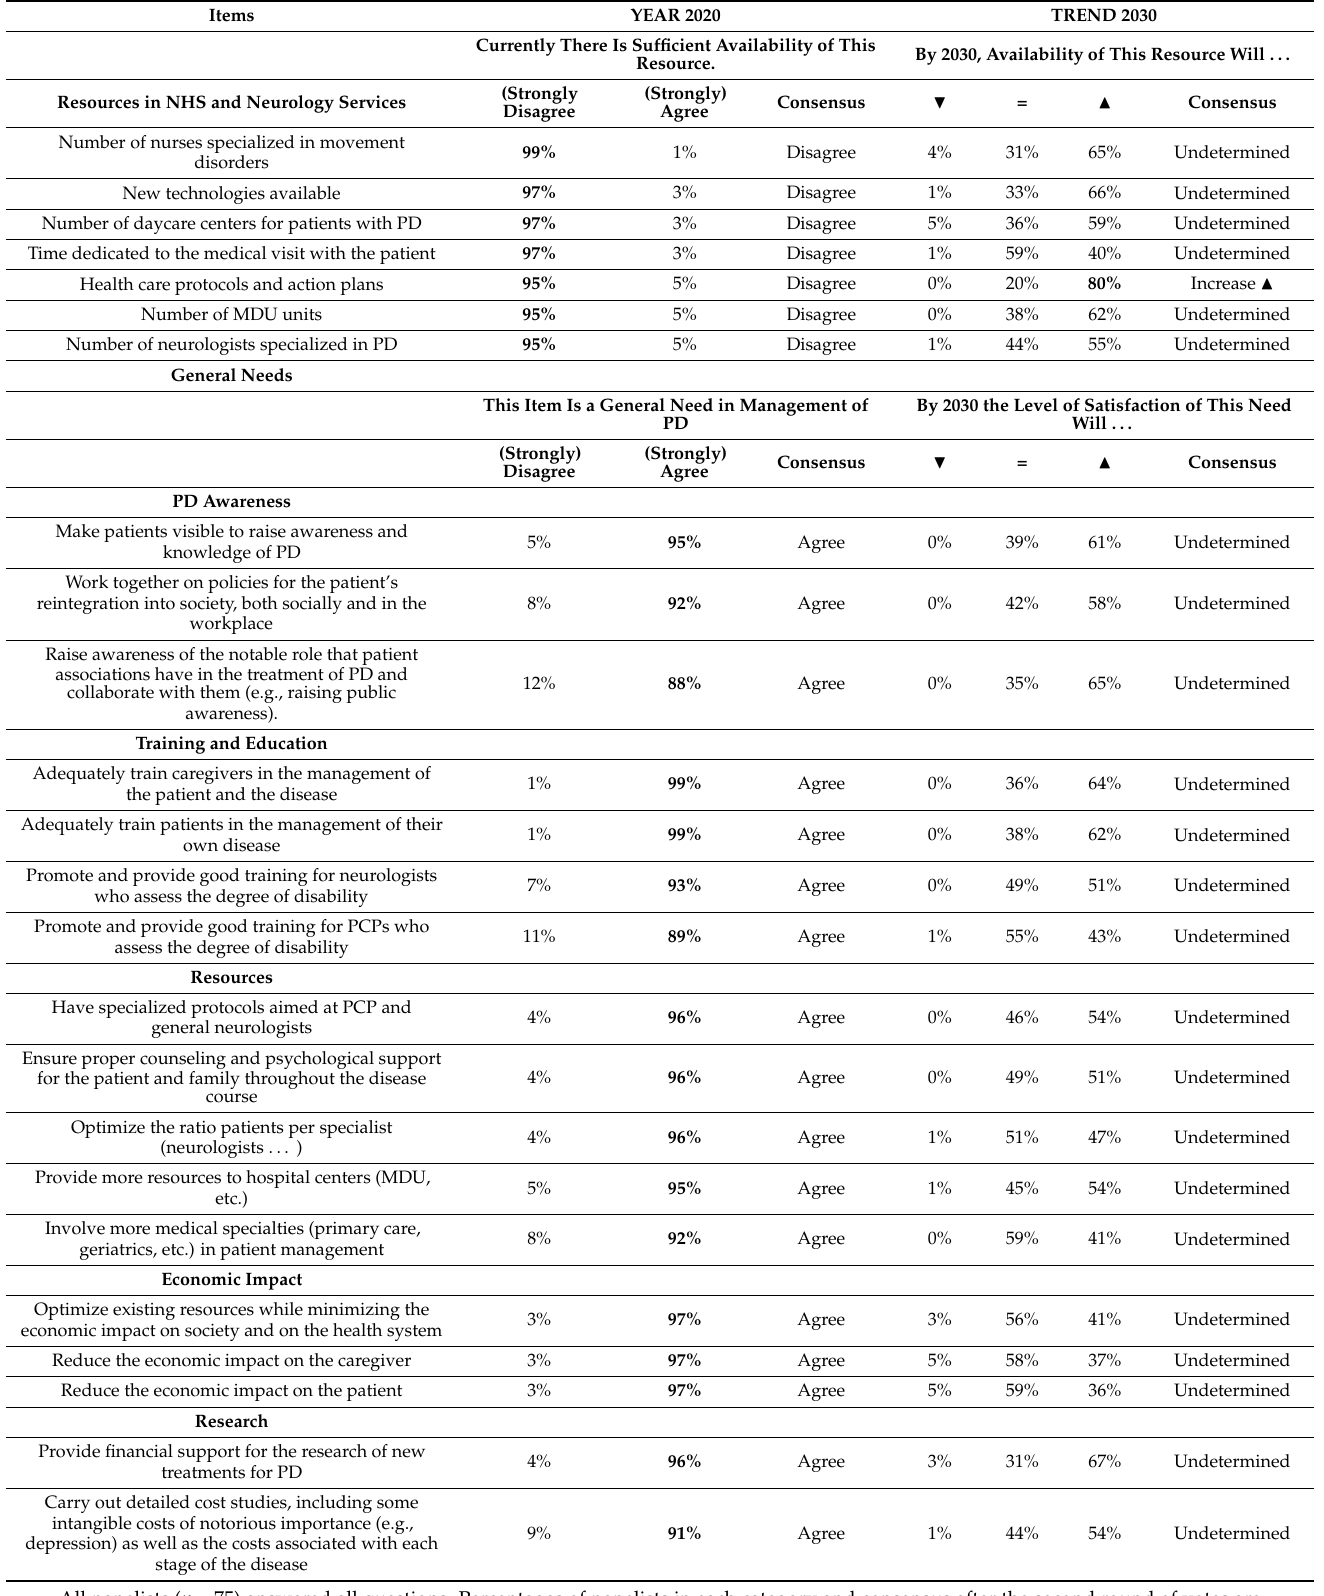
Table 7. Resource availability and general needs: present and